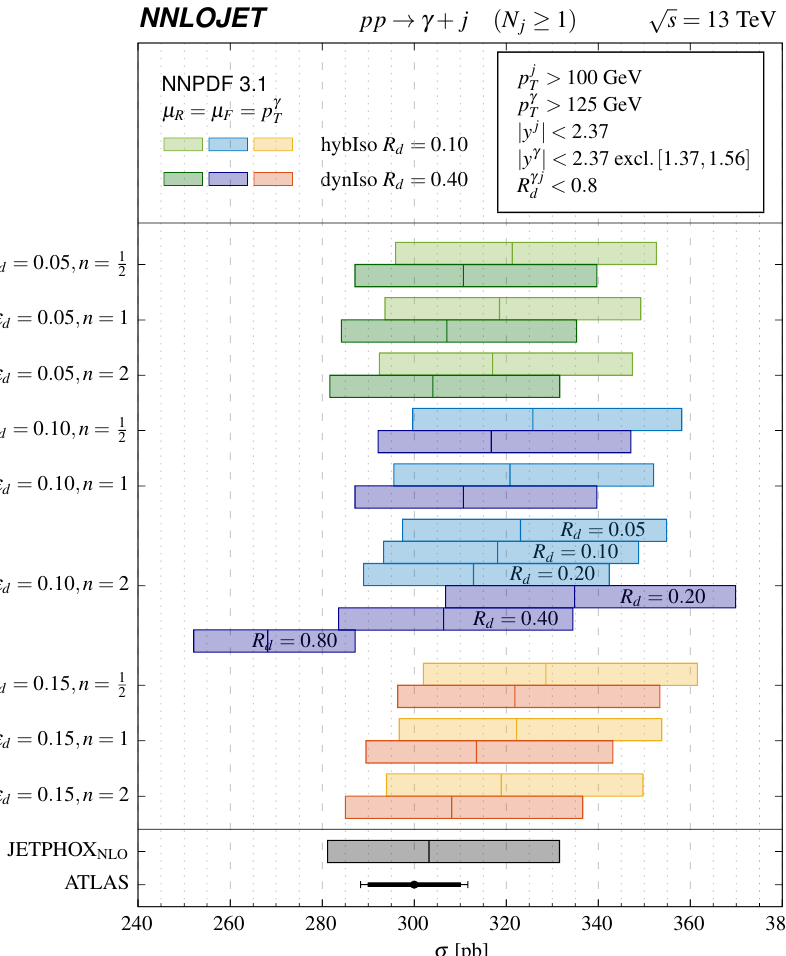
Figure 1 . Total cross section for di(cid:11)erent parameter choices ( " d = 0 : 05 ; 0 : 1 ; 0 : 15, n = 1 ; 1 ; 2) for 2 both dynamical photon isolation ( dynIso ) [30] (dark colours) and the dynamical cone part of the hybrid photon isolation ( hybIso ) (light colours). The default cone size for dynIso is R d = 0 : 4, while for hybIso it is R d = 0 : 1. For the speci(cid:12)c parameter choice " d = 0 : 1 ; n = 2 we also investigate variations of the cone size by factors 1 and 2. The (cid:12)xed cone parameters of the hybrid isolation are 2 chosen according to the ATLAS measurement [17]. The fixIso prediction (using JETPHOX [36]) and the ATLAS measurement are shown for